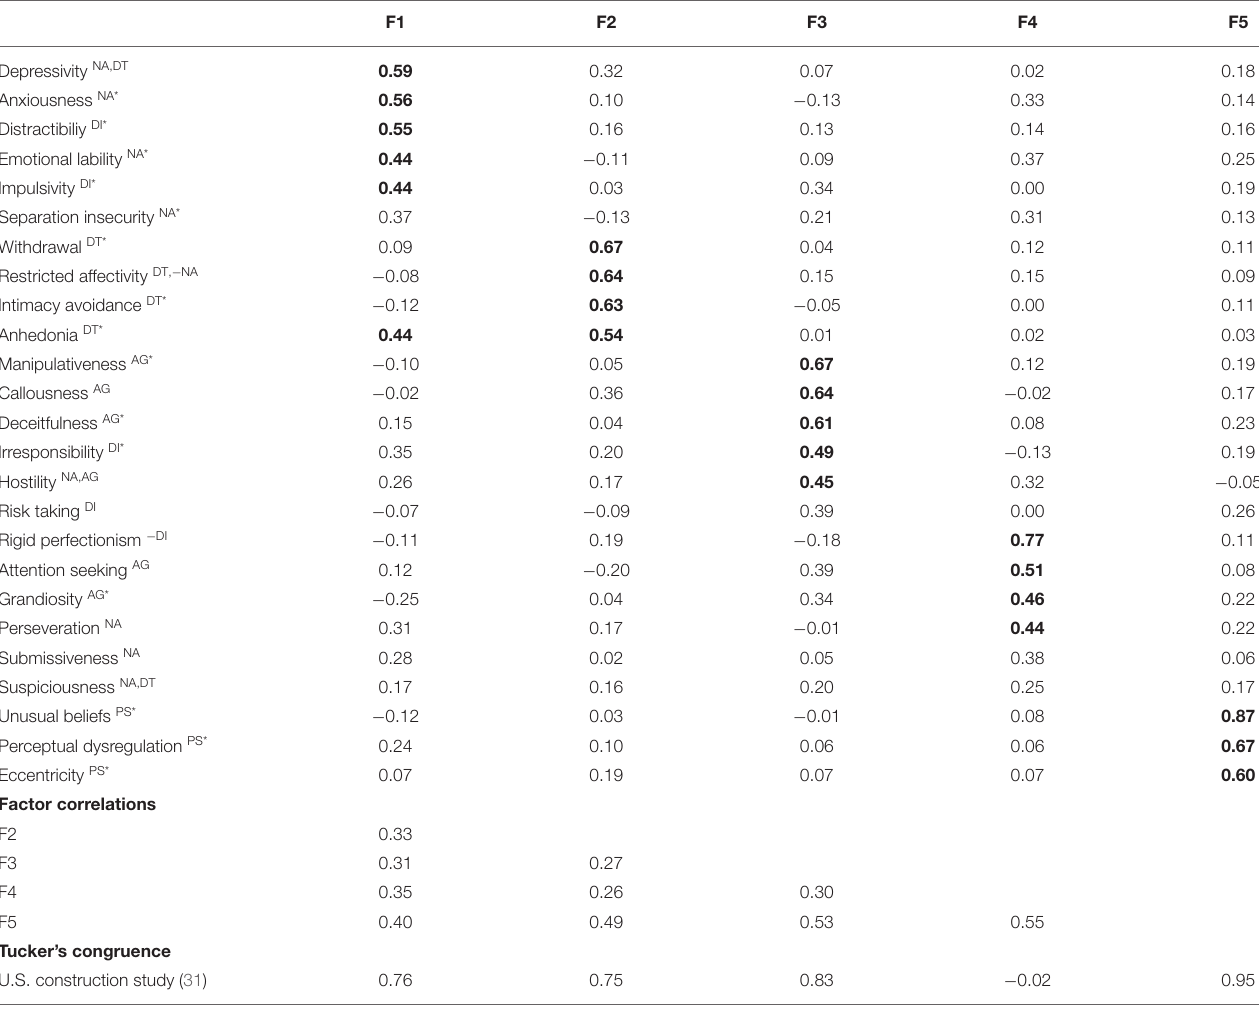
TABLE 3 | DSM-5 five-factor loadings, factor correlations, and congruence